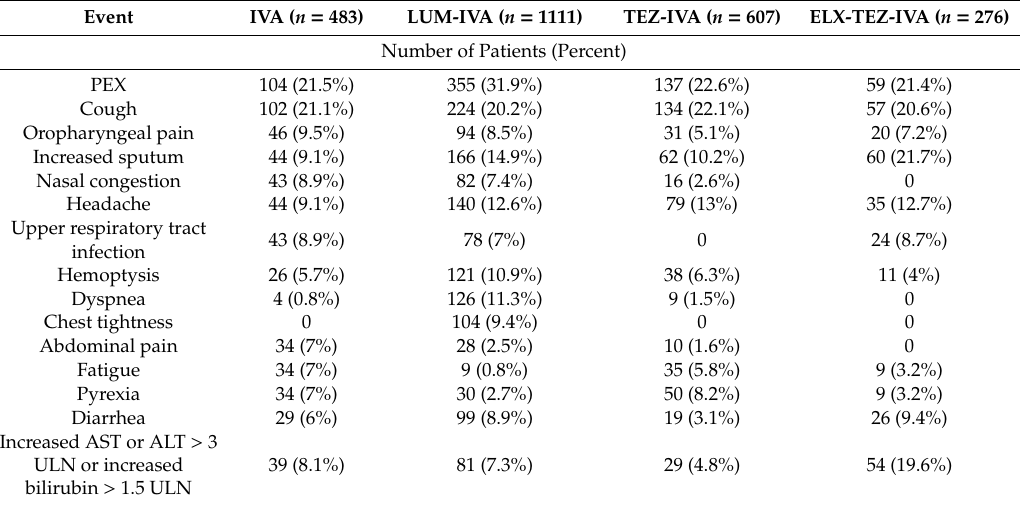
Table 2. Cumulative incidence of 15 most common adverse events among the four CFTR modulators currently available in clinical